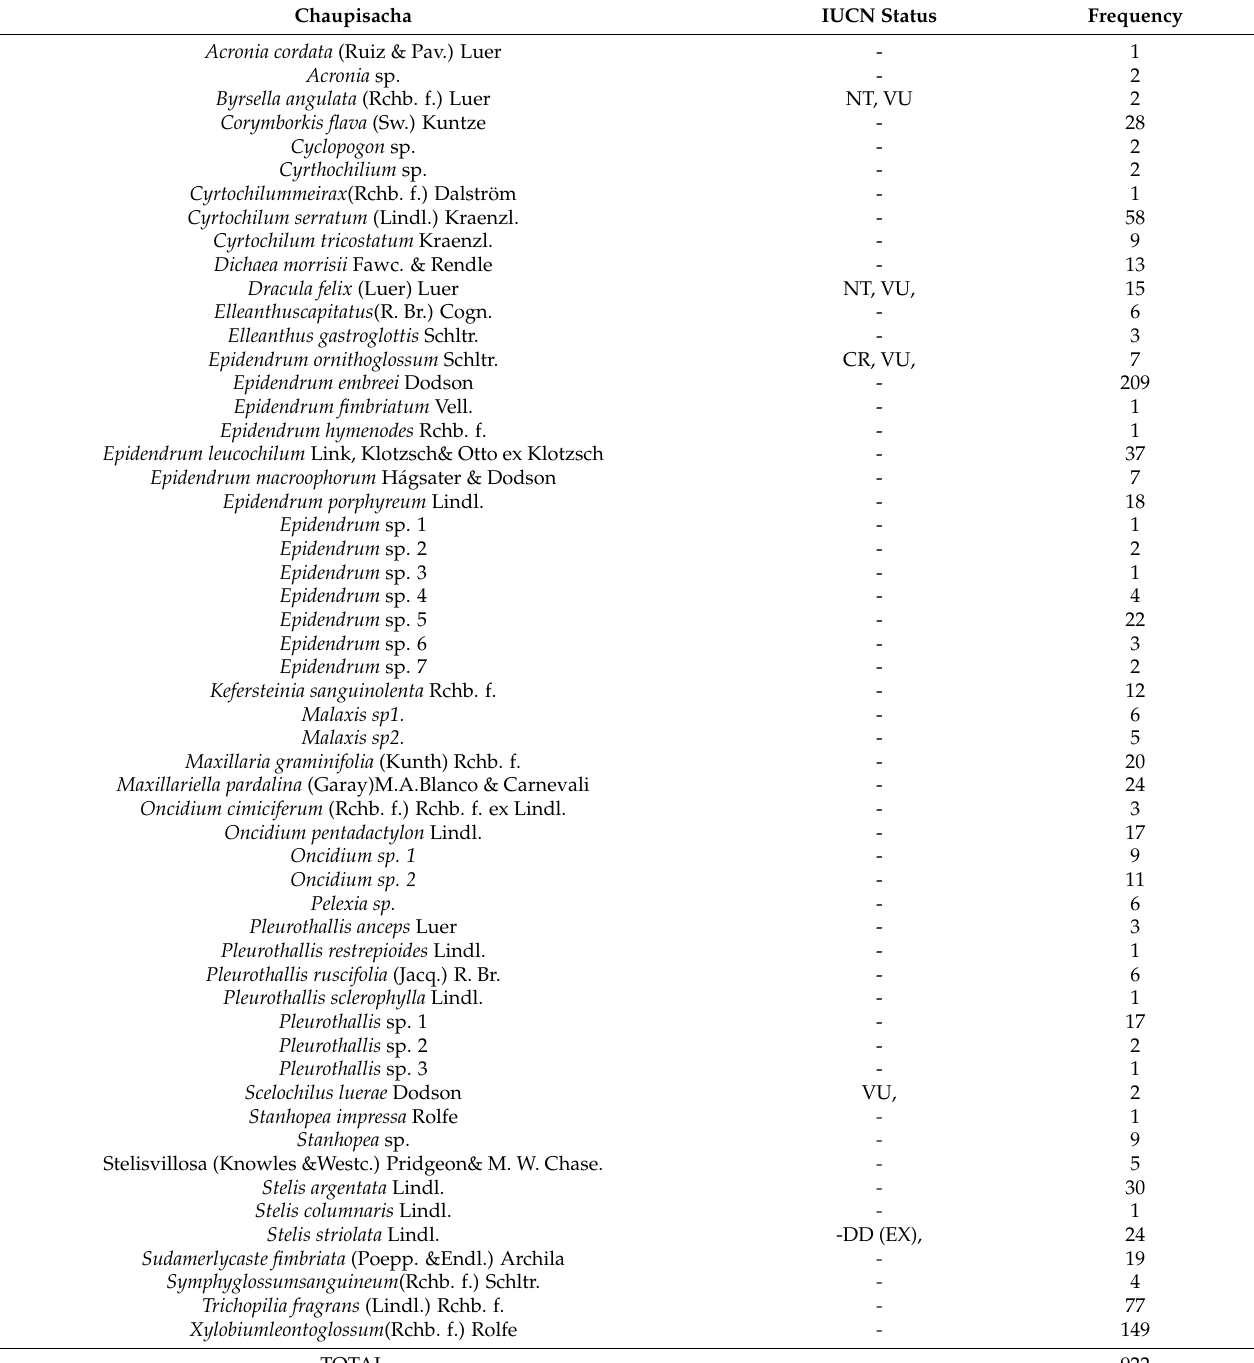
Table A1. List of species registered in the Chaupisacha sector. Chaupisacha IUCN Status Acronia cordata (Ruiz & Pav.)